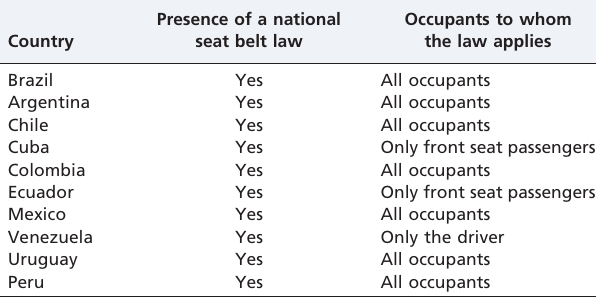
Table 3 - Countries’ seat belt laws and the occupants of the vehicles who are bound by such laws.